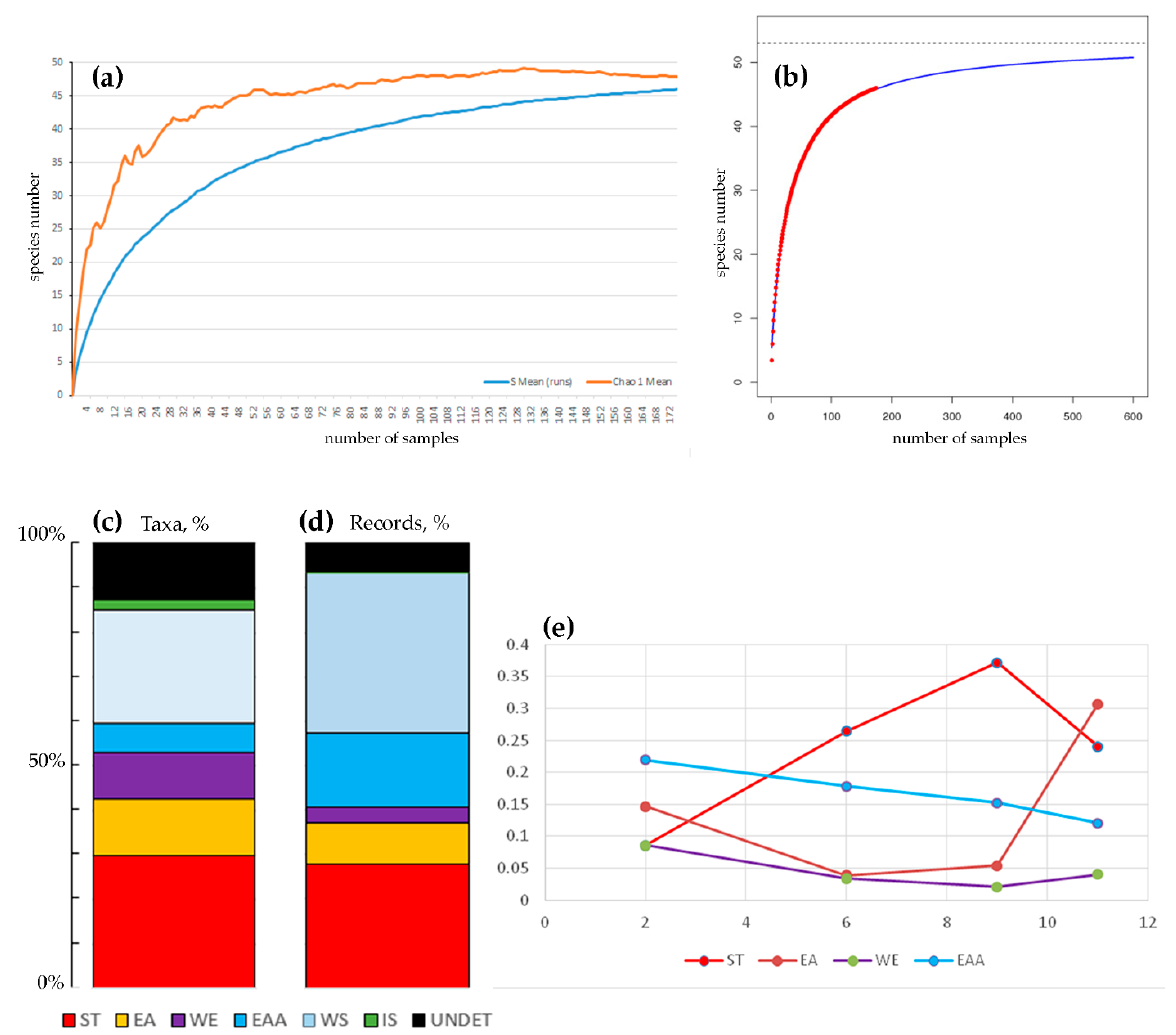
Figure 3. Analysis on the whole dataset of the cladoceran records in Jeju Island: ( a ) Sample-based rarefaction curve (S Mean) and estimator curve (Chao 1 Mean) for the water bodies/season. ( b ) The Species Sampling Relationship (SSR) model. Red dots—simulated species accumulation curve, blue line—rational function approximation, ( c ) All revealed taxa belonging to different faunistic complexes. ( d ) Total records of taxa belonging to different faunistic complexes. ( e ) Rate of records belonging to three faunustic complexes in general pool during four different months.